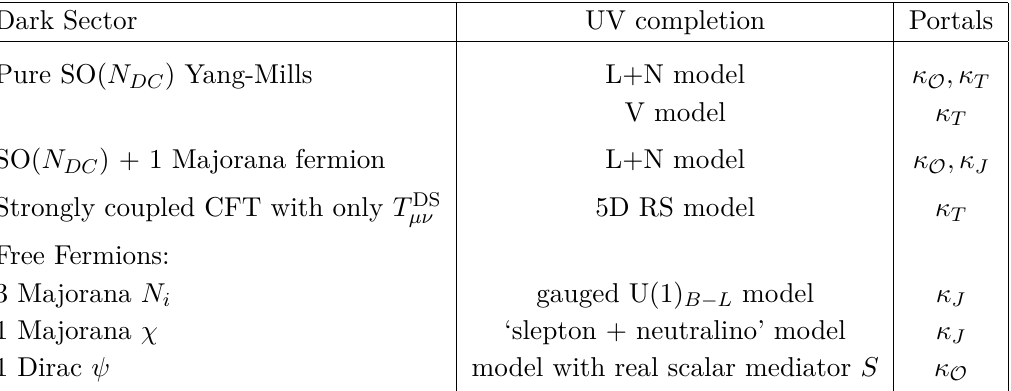
Summary of benchmark models that serve as examples of dark sectors with irrelevant portals interactions.